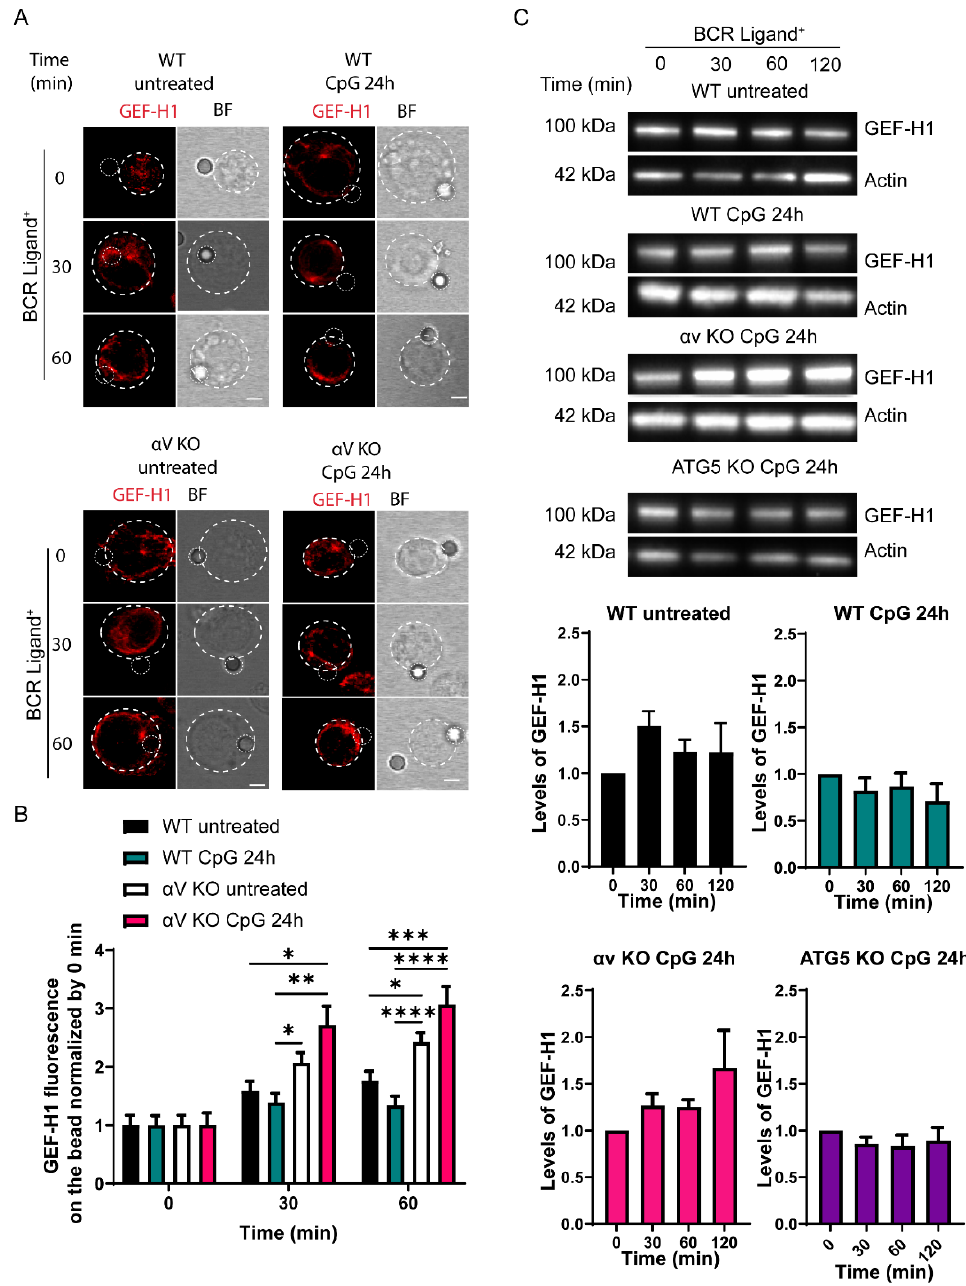
Figure 6. Autophagy induced by TLR stimulation decreases the levels of GEF-H1 at the IS. ( A ) Representative confocal images of control and CpG pre-treated B cells stained for GEF-H1 (red). ( B ) Fold change of GEF-H1 at the area of the bead, normalized by the bead fluorescence at time 0. * p < 0.05, ** p < 0.01, *** p < 0.001, **** p < 0.0001. N = 3. (>100 cells). Two-way ANOVA with Sidak’s multiple comparison test. ( C ) Immunoblot showing levels of GEF-H1 in control and CpG pre-treated cells, activated on antigen-coated plates at different time points. Bottom: quantification of GEF-H1 levels normalized by time 0. N = 3.